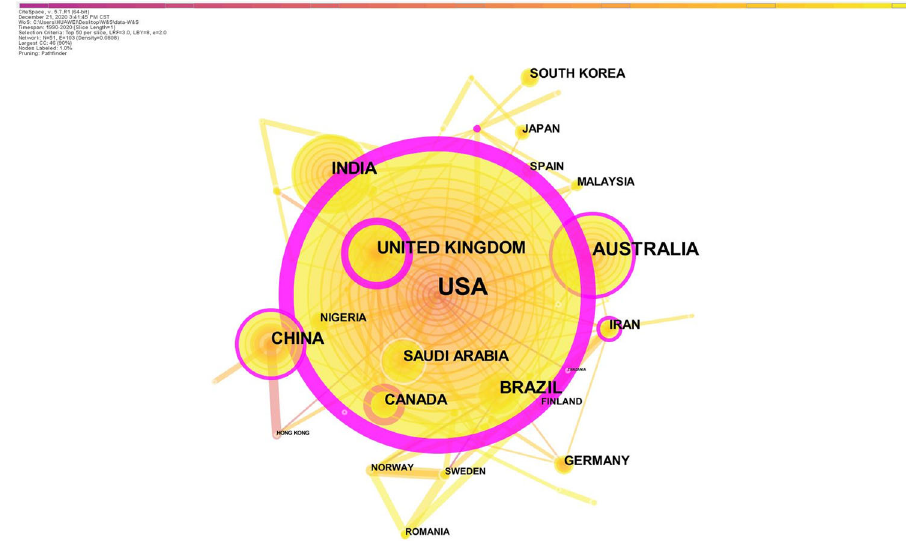
Fig. 2 The distribution of countries. The network map of countries related to oral health literacy